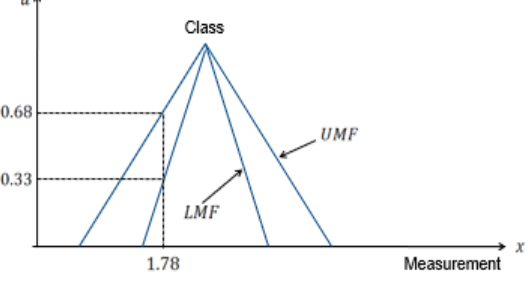
Figure 1. Representation of Type − 2 fuzzy sets with primary membership